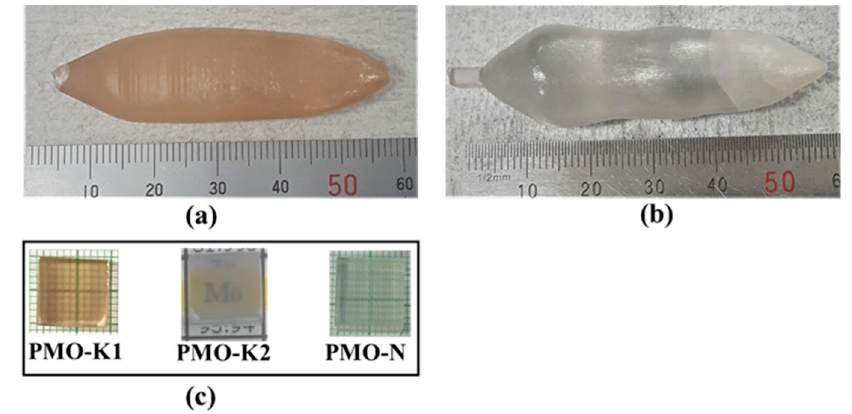
Figure 2. Photographs of the PMO crystals grown from ( a ) the first batch, ( b ) second batch of synthesized powders, and ( c ) 10 mm × 10 mm × 10 mm polished samples from crystals grown from the first and second batch powders and that received from NIIC.